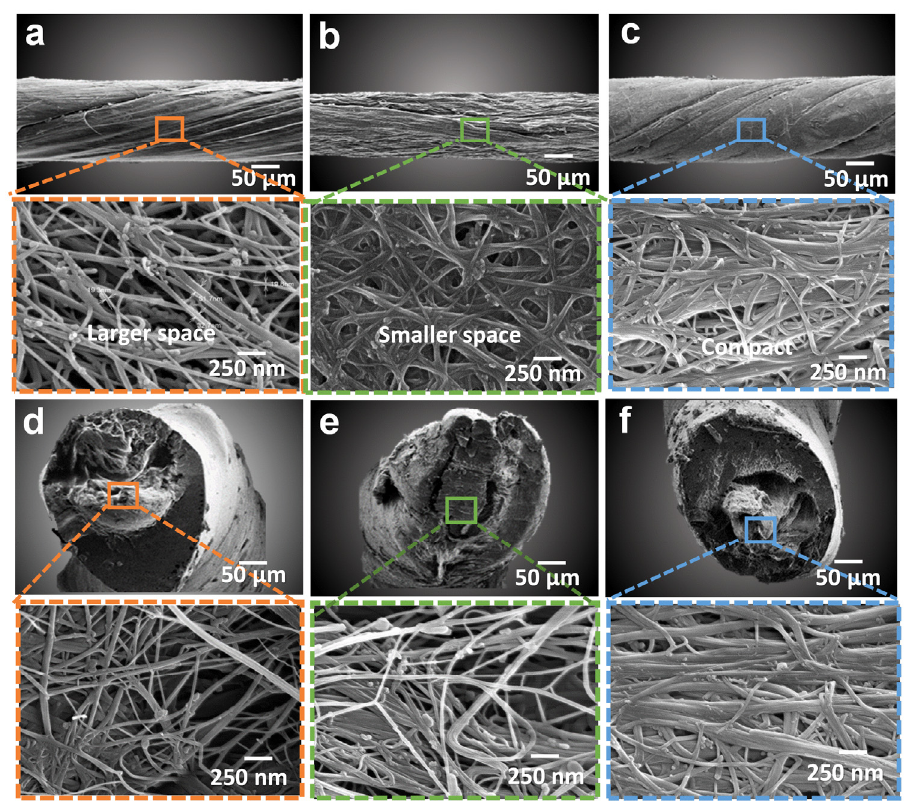
Figure 2. SEM images of ( a , d ) Pristine CNT yarn; ( b , e ) Acidified CNT yarn; and ( c , f ) Esterified CNT yarn in longitudinal and cross-sectional direction, respectively presenting loosely packed to highly dense CNTs structure.